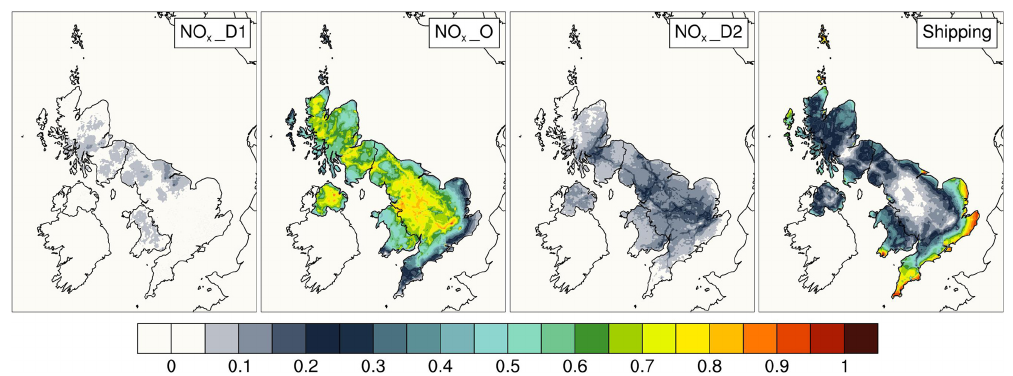
Figure 4. Spatial distributions (at the 5km × 5km model grid resolution) of the first-order sensitivity indices for modelled surface concen- trations of NO 2 . D indicates emissions from a dominant sector and O indicates grouped emissions from the rest of the sectors. For NO x emissions the dominant sectors are energy production (D1) and road transport (D2). The shipping emissions variable combines emissions of all relevant